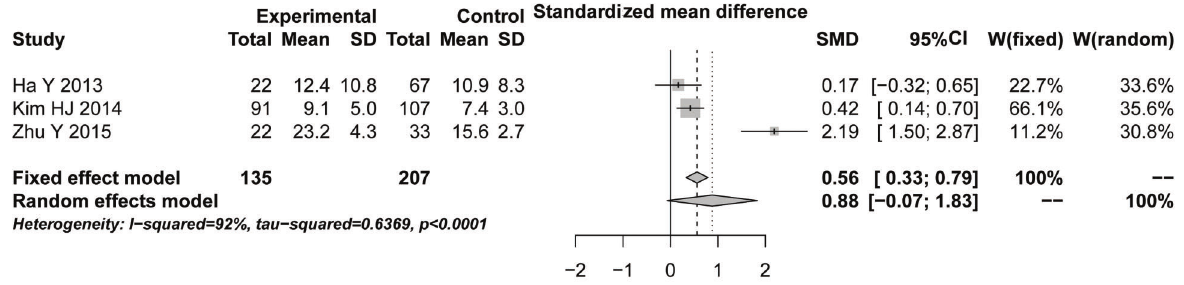
Figure 5. Forest plots for length of hospital stay. UT (experimental group): upper thoracic; LT (control group): lower thoracic. See Table 1 for reference numbers of cited studies. UT